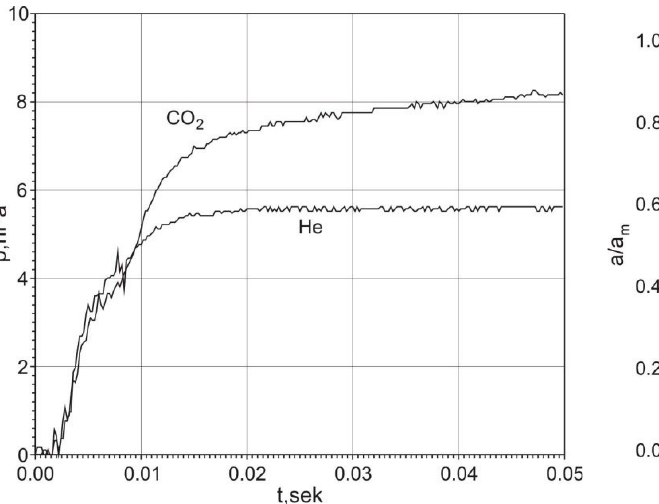
Figure 6: Amount of desorbed CO